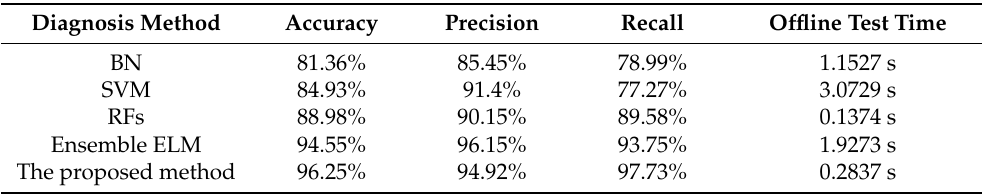
Table 7. Validation and comparison with other